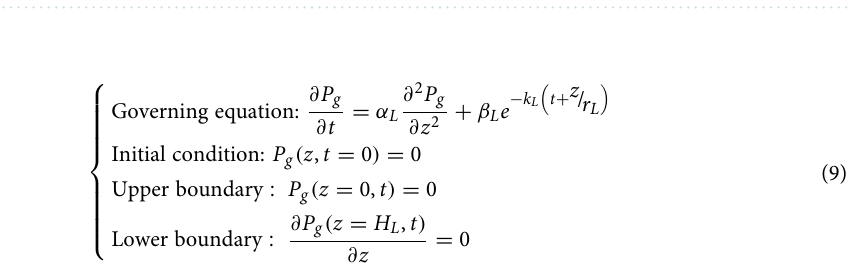
Figure 2. Comparison of the calculation values of gas pressure in this study and the value calculated by Li et al. 29